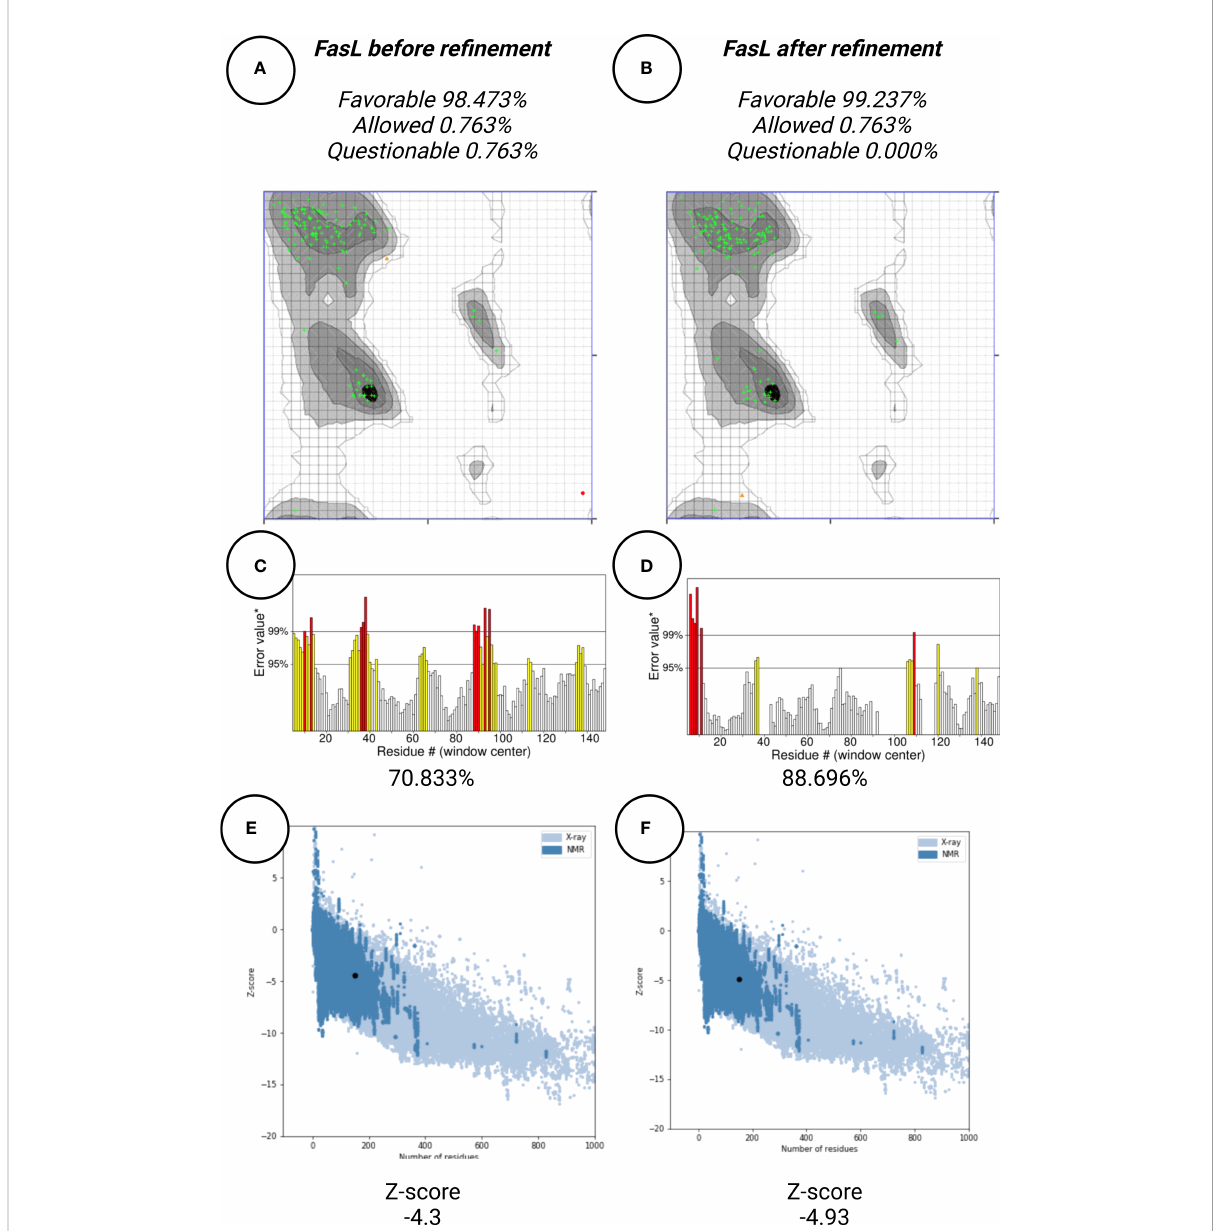
FIGURE 8 Protein quality veri fi cation for FasL tertiary structure. After re fi nement, FasL structure was favorable (A, B) In the Ramachandran plot, more residues are located in favorable regions. (C, D) ERRAT score was improved from 70.833% to 88.696%. A score over 80% shows the re fi ned structure has good quality. (E, F) ProSA Z-score was improved from -4.3 to -4.93 which is within the acceptable range for structures with the same aminoacid